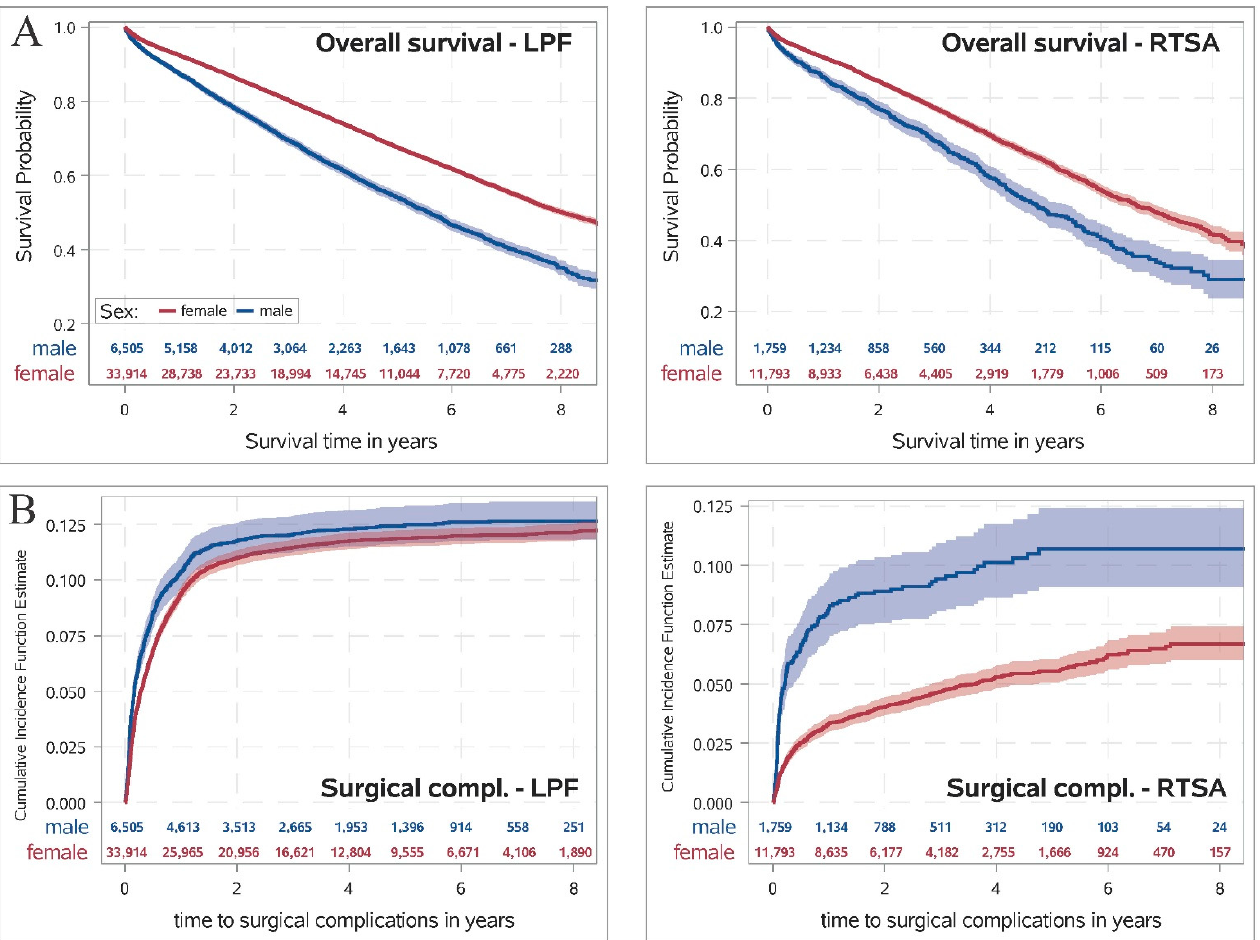
Figure 2. ( A ) Survival probability determined by Kaplan–Meier estimate for overall survival comparing female and male sex for both treatment groups. Differences between both sexes were tested using a two-sided log-rank test. ( B ) Cumulative incidence function determined by Nelson–Aalen estimate for surgical complications during follow-up for both treatment groups separately, where death was considered as a competing risk. Differences between female and male sex were tested using the two-sided Gray’s test. p -values were adjusted by the Bonferroni–Holm method. Locked plate fixation—LPF, reverse total shoulder arthroplasty—RTSA. Table 1. Cumulative incidence function/event rates of primary outcomes and 95% confidence intervals depending on sex and treatment group.